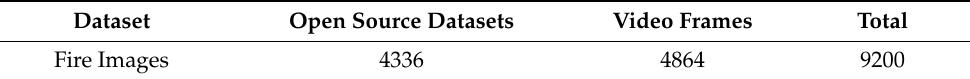
Table 1. Distribution of fire images in the